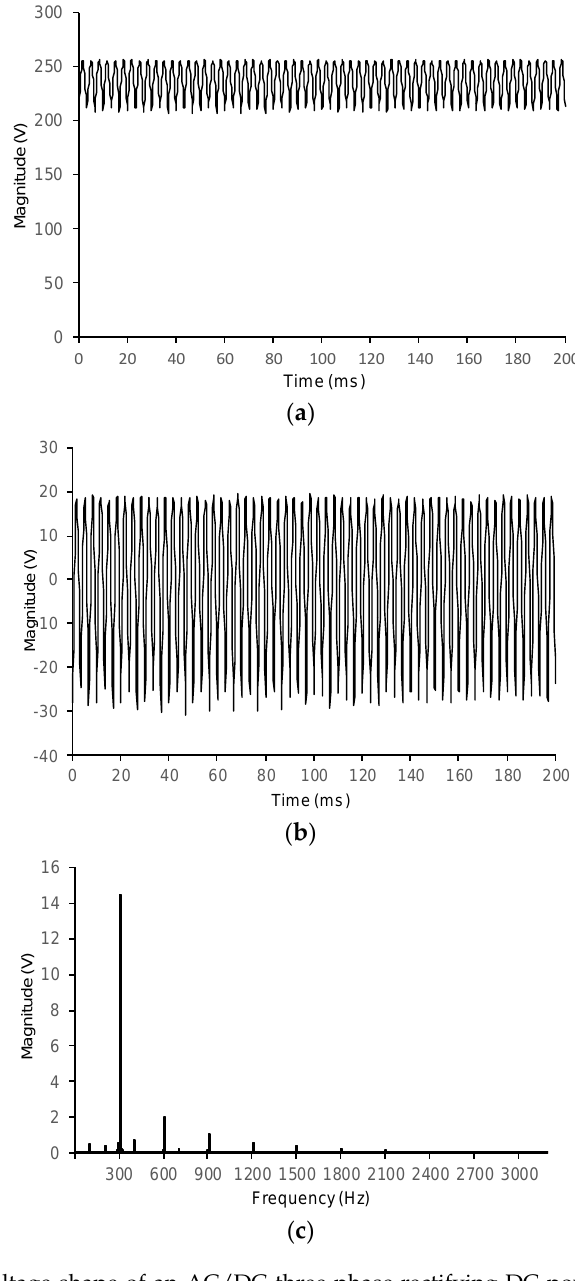
Figure 6. ( a ) DC voltage shape of an AC/DC three-phase rectifying DC power source, ( b ) ripple content, and ( c ) spectral components in voltage ripple excluding the DC component.